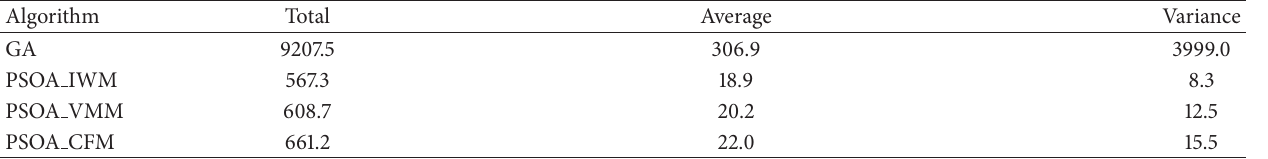
Table 7: ANOVA verification of completion